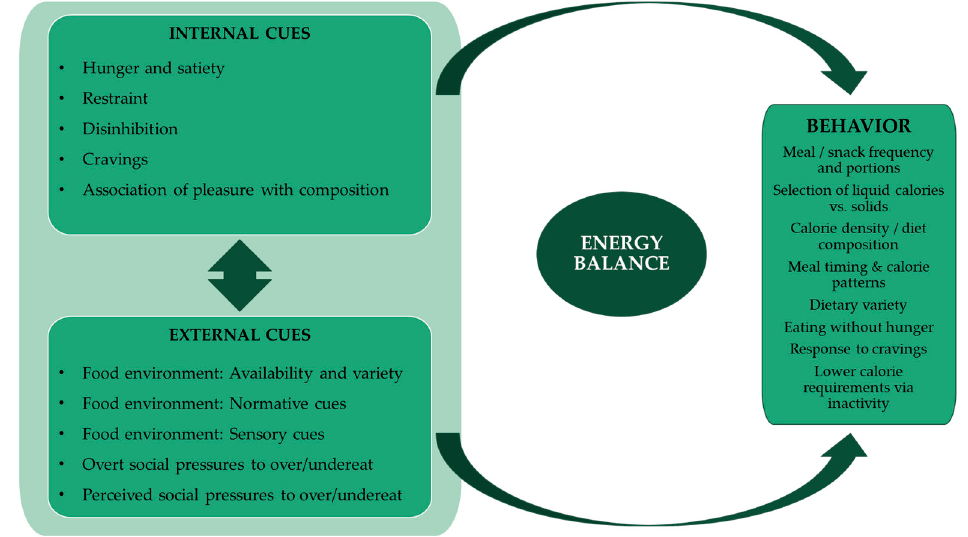
Figure 2. Model for interplay of external and internal factors modulating overeating and undereating.